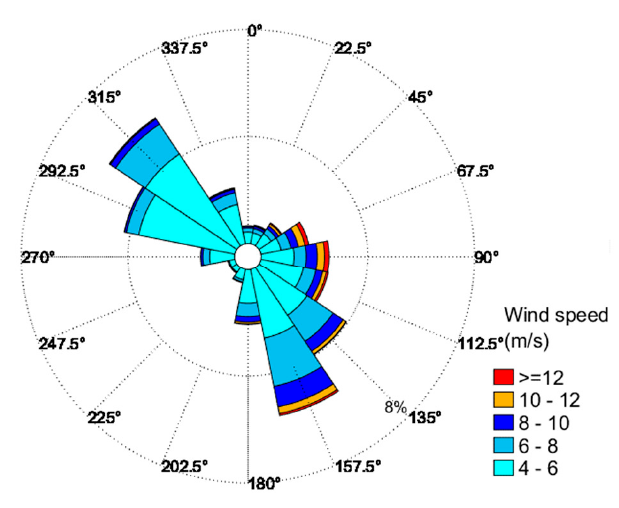
Figure 3. Wind regime at Cesenatico in the period 2010–2020: distribution of the 10 ′ average hourly wind speed at 10 m height.